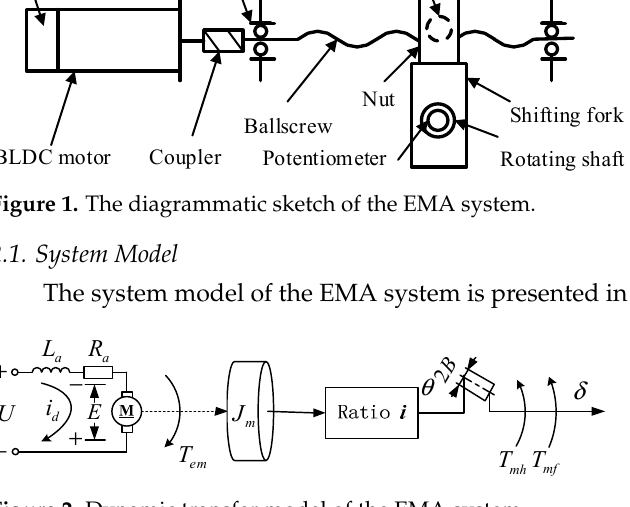
Figure 2. Dynamic transfer model of the EMA system.